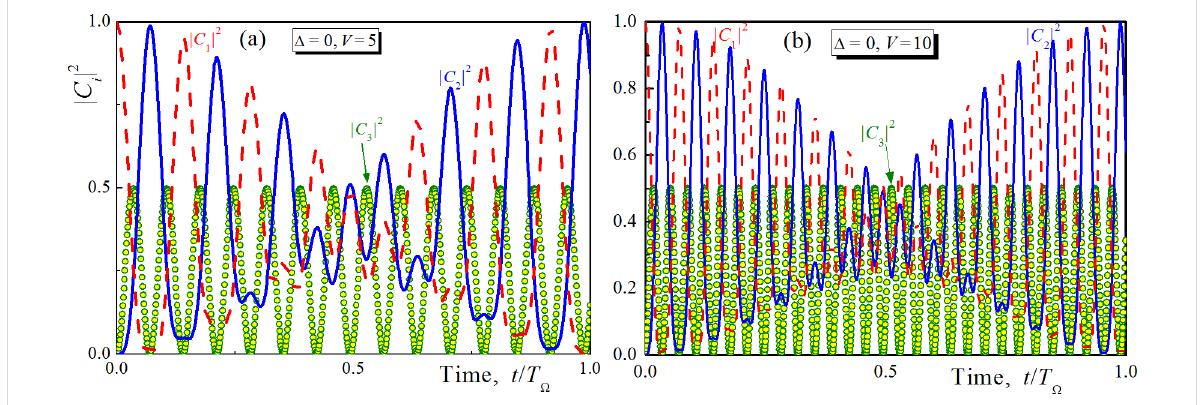
Figure 2: Analytical solution of Equation 7 obtained in the limit Δ→ 0 for two different magnetic field strengths: V = 5 (a) and V = 10 (b). Dashed lines, solid lines and circles are for | C 1,2,3 | 2 , respectively. The decrease of efficiency of the population transition is prevented by increasing the coupling be- tween the qubit states. For convenience, hereinafter in the figures, the values of Δ and V are normalized to the characteristic energy ℏΩ